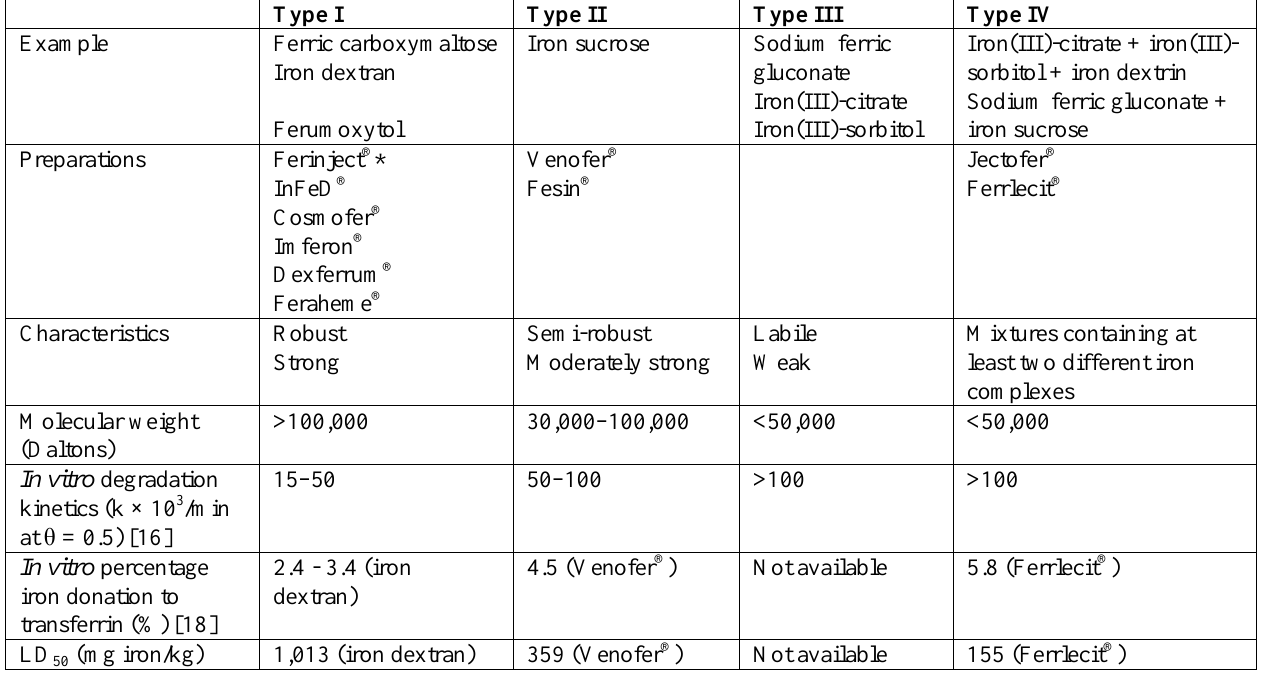
Table 1. Classification of intravenous iron carbohydrate complex preparations